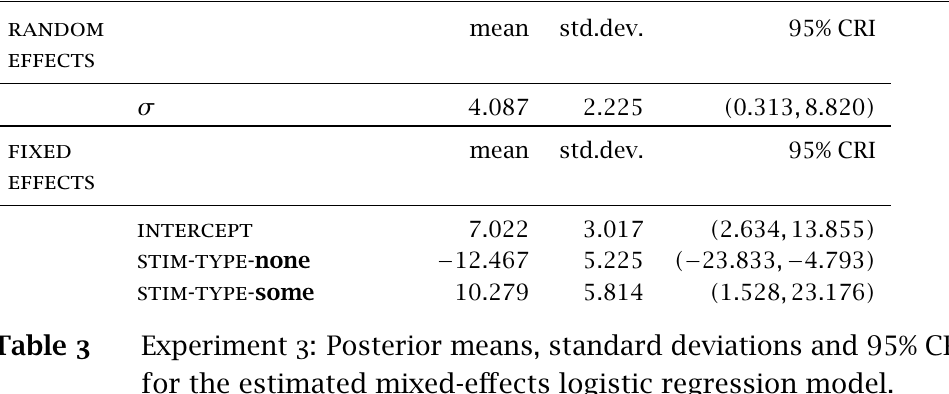
Experiment 3 : Posterior means, standard deviations and 95 % CRIs for the estimated mixed-effects logistic regression